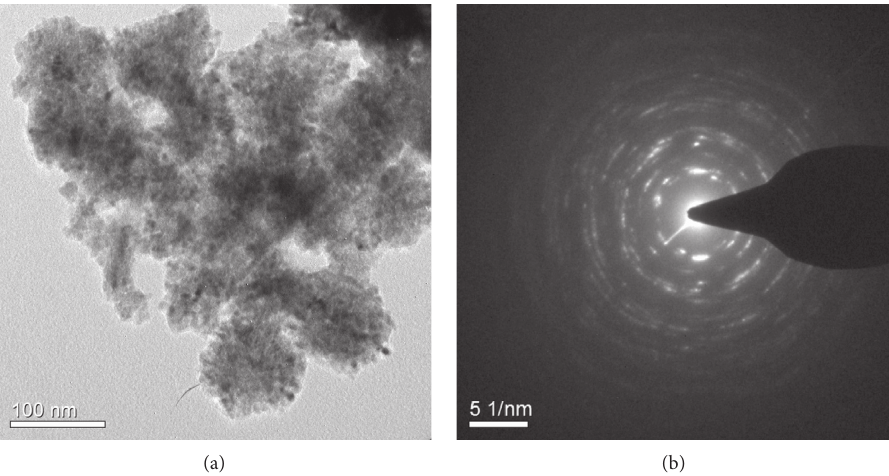
Figure 5: (a) TEM image and (b) SAED pattern of biosynthesized CuO NPs from copper (II) nitrate trihydrate and leaf extract of Catha edulis in 1:10 ratio (w/v).